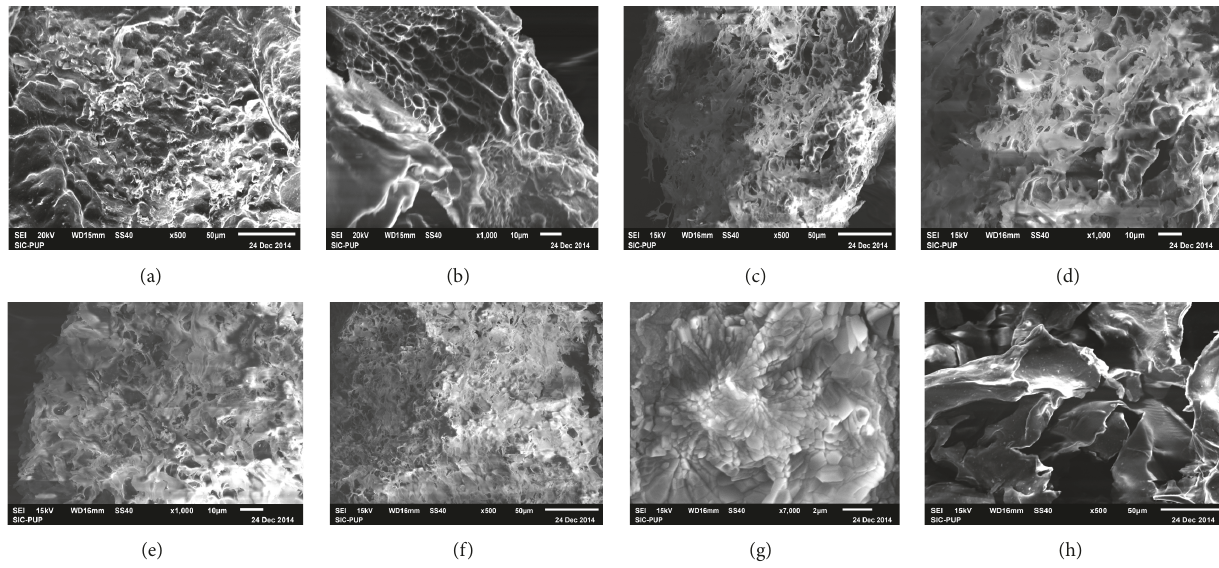
Figure 6: SEM images of different PECs between OKG and CH at concentration ratios 2: 8 (a), 3: 7 (b), 4 :6 (c), 5 :5 (d), 6: 4 (e), 7 : 3 (f), 8: 2 (g), and 9: 1